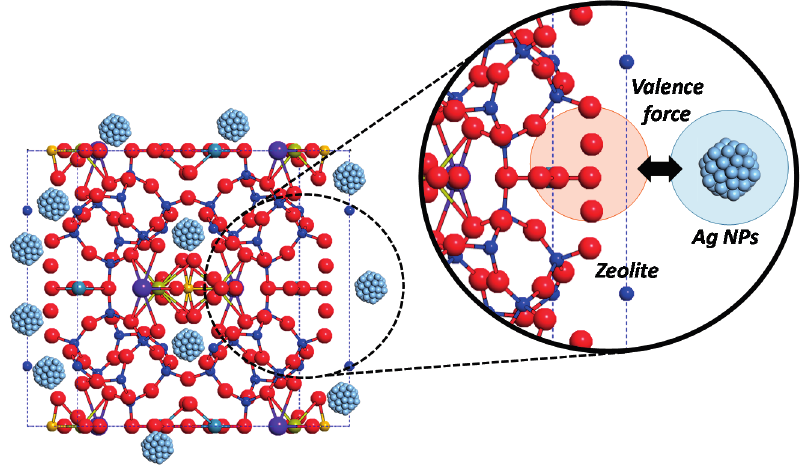
Figure 8. Ball-and-stick model proposed for the adhesion mechanism of the AgNPs on the clinoptilolite